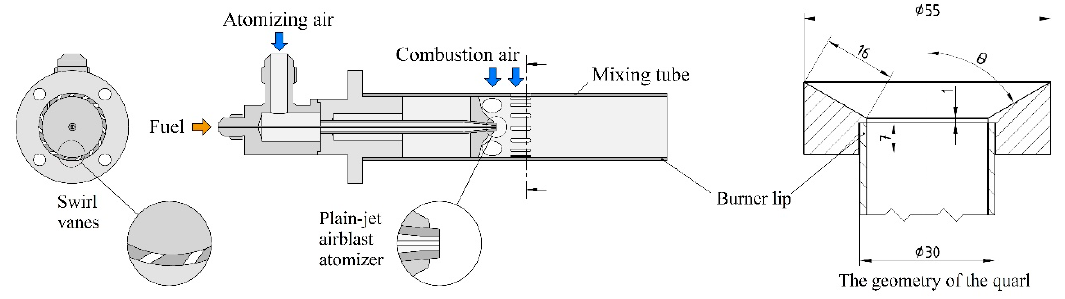
Figure 2. The investigated burner and the used quarl.